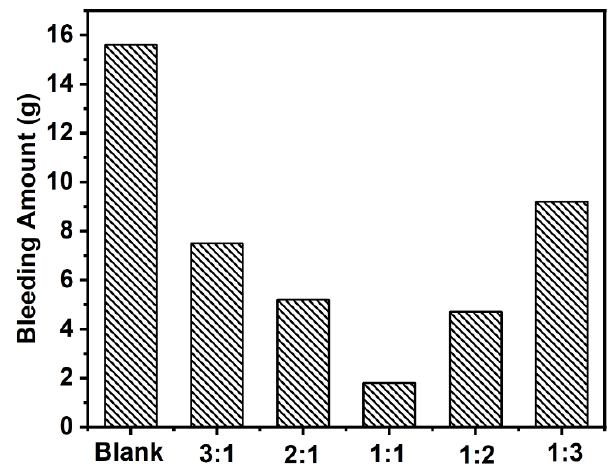
Figure 2. Bleeding amounts of the cement pastes mixed with different polymers.